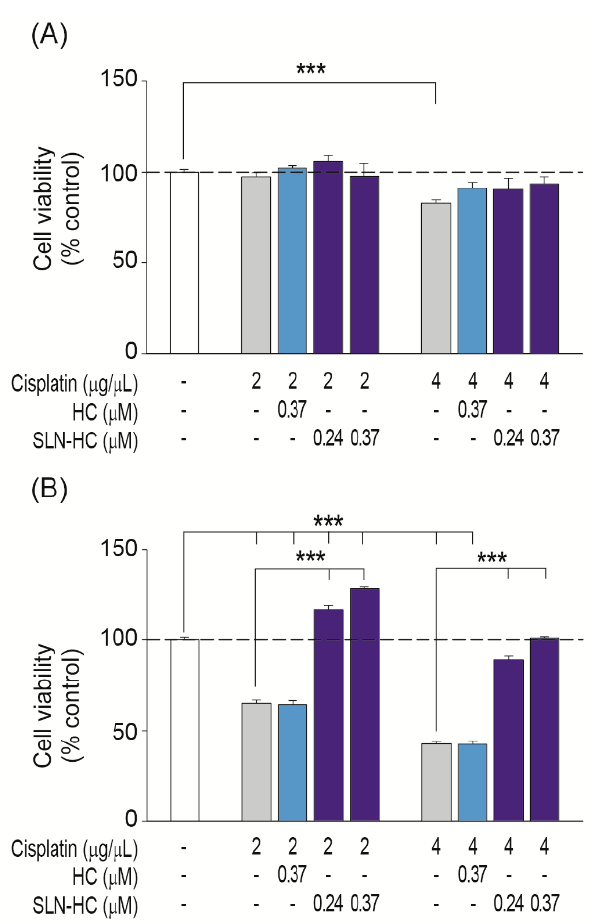
Figure 6. Comparative e ff ects of SLN–HC and hydrocortisone on HEI-OC1 cell viability. Cell viability was evaluated by Cell Proliferation kit II (XTT) assay. HEI-OC1 cells were treated for 24 h ( A ) or 48 h ( B ) with di ff erent concentrations of hydrocortisone (HC) either alone or combined with SLNs (SLN–HC) in the absence or presence of 2 or 4 µ g / mL cisplatin. Results are shown as mean ± SEM from four independent experiments. The significance of the di ff erences was evaluated using one-way ANOVA testing, *** p <